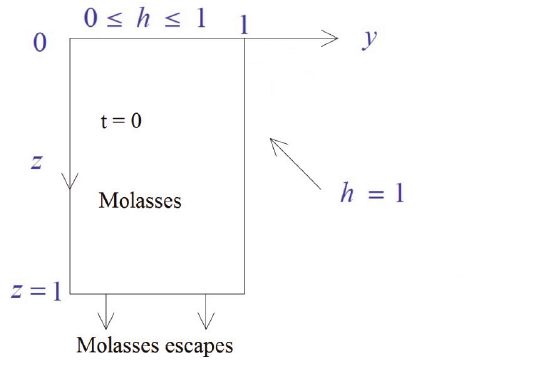
Figure 4. The initial conditions (3.2) and (3.3) for the partial differential equation (3.1).